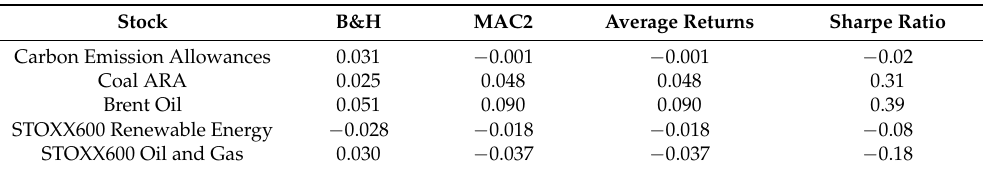
Table A7. Annualized daily (every fifth month) returns of MAC2 (C = every fifth month, 2 is the numbers of observations in the rolling window), average returns and Sharpe